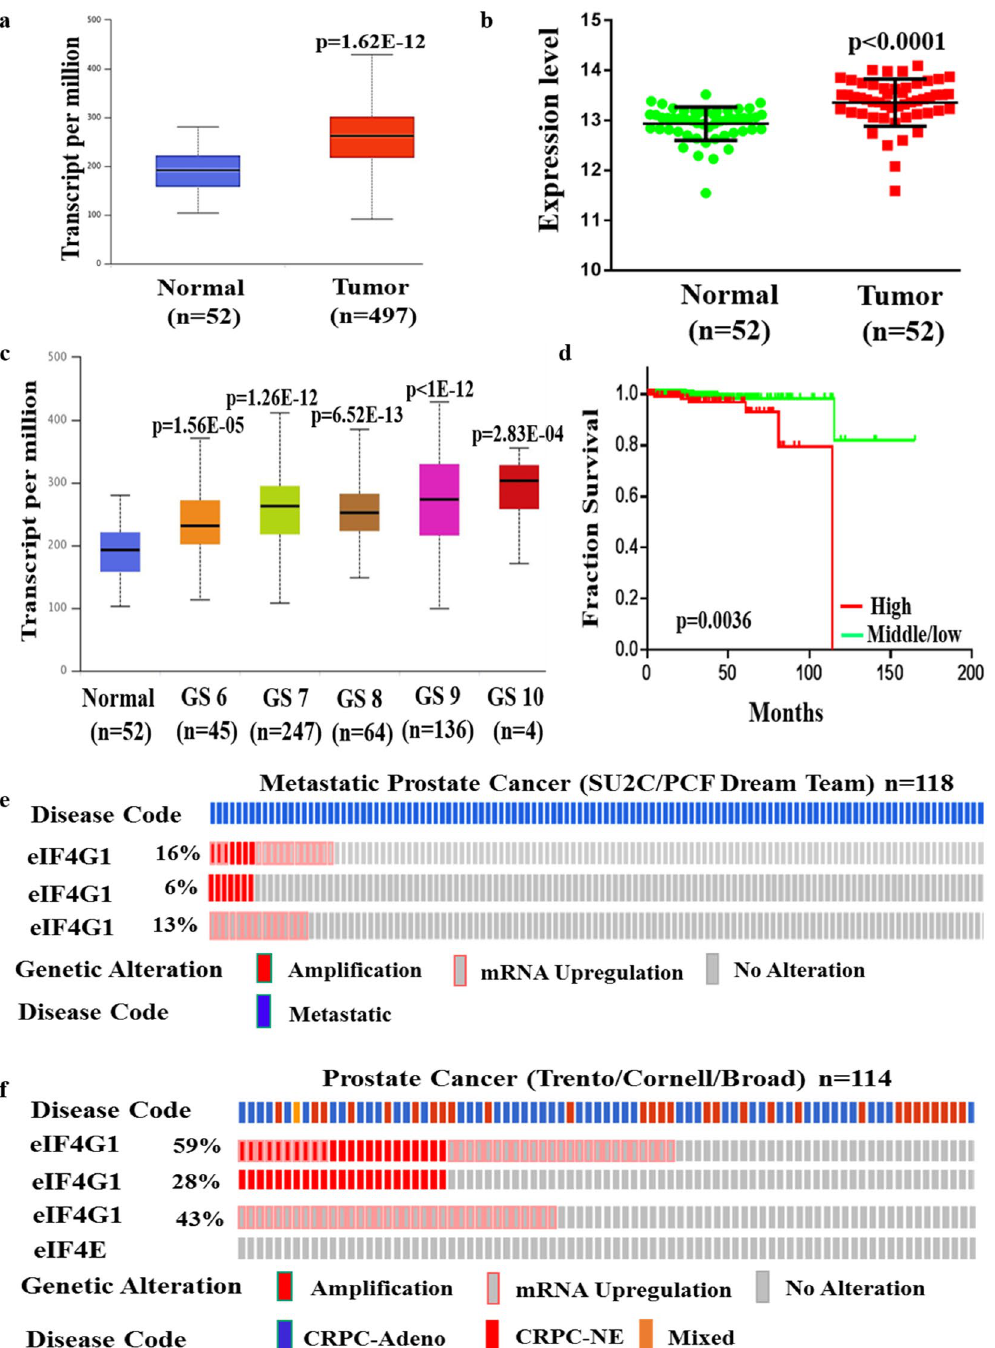
Figure 1. eIF4G1 is over-expressed in multiple clinical cohorts of PCa: Analysis of eIF4G1 expression in PCa samples from different databases: ( a ) mRNA levels of eIF4G1 in Normal vs prostate tumor samples from TCGA dataset. ( b ) mRNA levels of eIF4G1 in Paired Normal vs prostate tumor samples from TCGA dataset. ( c ) A Graded increase in eIF4G1 with increasing Gleason Score (GS) (TCGA). ( d ) High expression of eIF4G1 decreases survival probability (TCGA data set, time in months). ( e ) eIF4G1 is amplified and overexpressed in 16% patients with Metastatic Prostate Cancer dataset. ( f ) eIF4G1 is amplified and overexpressed in 59% patients in CRPC-Neuroendocrine Prostate Cancer dataset, while no change is observed in eIF4E. p-values are indicated as * < 0.05, ** < 0.01, *** <